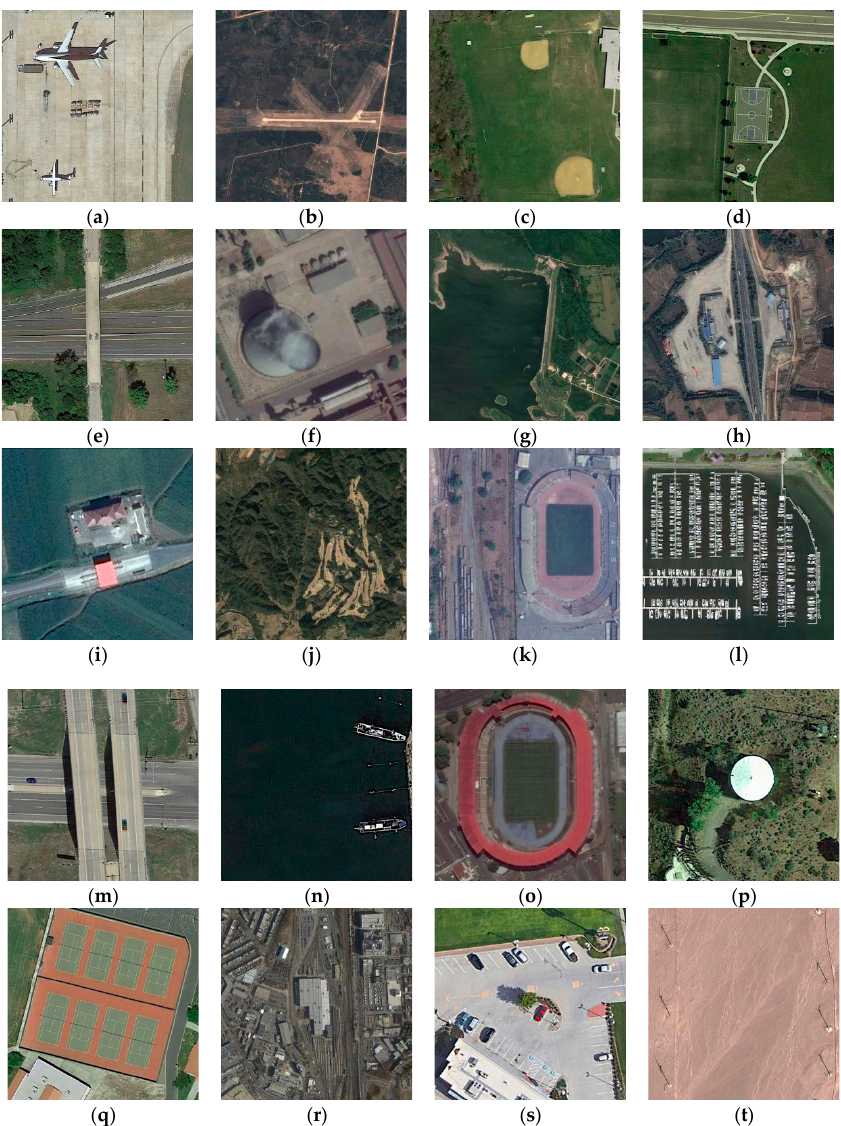
Figure 9. All 20 classes object ( a – t ) in DIOR dataset. ( a ) Airplane; ( b ) Airport; ( c ) Baseball field; ( d ) Basketball court; ( e ) Bridge; ( f ) Chimney; ( g ) Dam; ( h ) Expressway service area; ( i ) Expressway toll